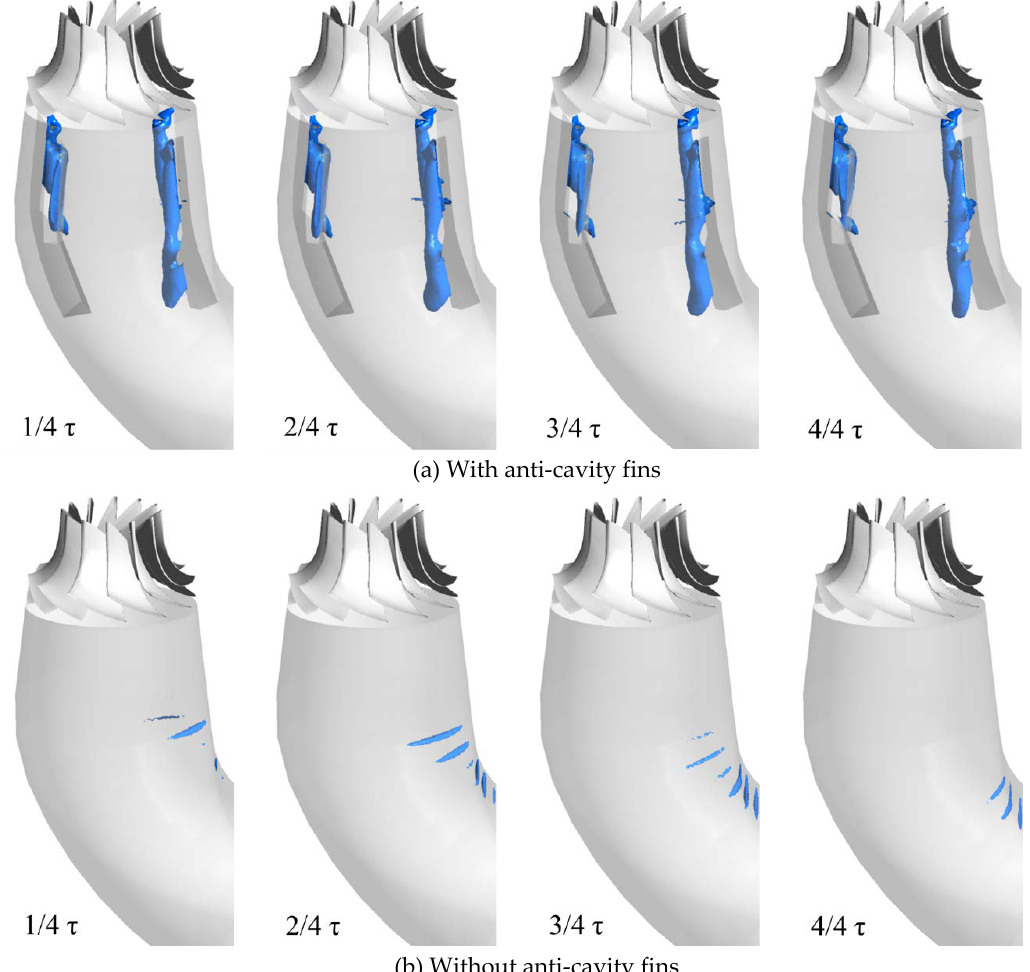
Figure 9. Iso-surface distributions of pressure in the DT during one runner revolution at a GV of 12°: (a) with anti-cavity fins; and (b) without anti-cavity fins.